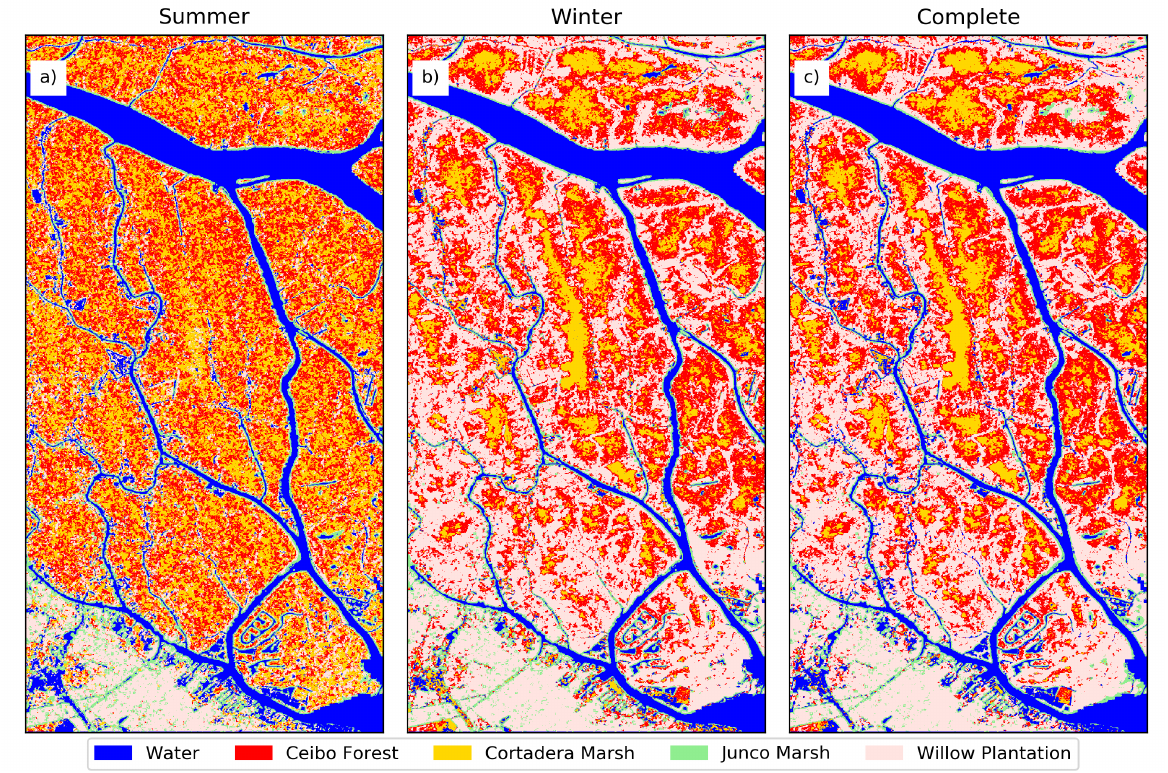
Figure 4. Products of the Random Forest classifications calculated over the: a) Intensity+GLCM-Summer-VH dataset; b) Intensity+GLCM-Winter-VH dataset; c) Intensity+GLCM-Complete-VH